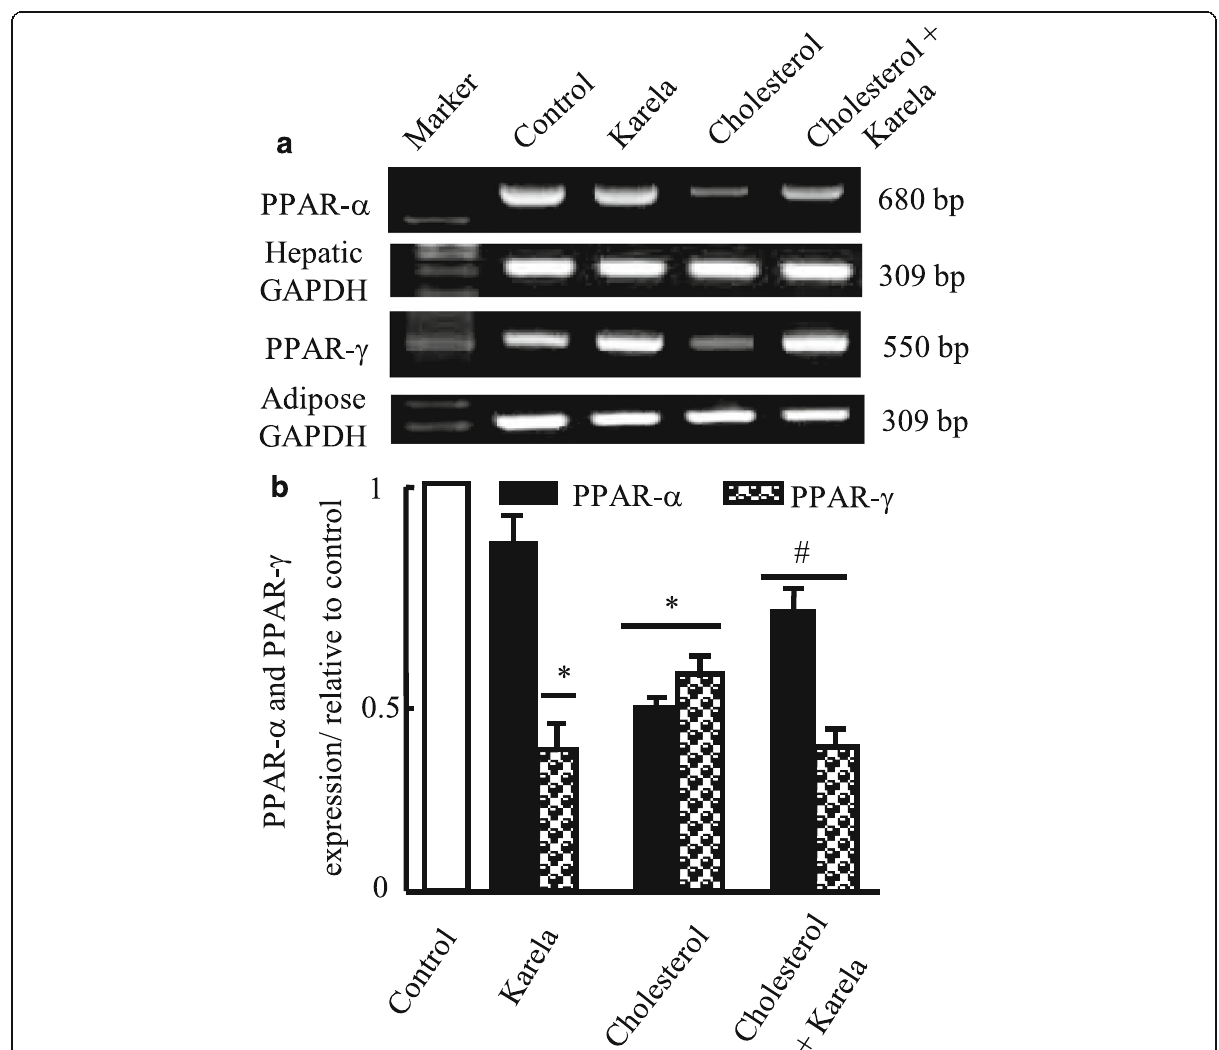
Fig. 6 Protective effect of karela on changes in PPAR- α and PPAR- γ expression induced by hypercholesterolemia in liver and adipose tissue. Hypercho- lesterolemic rats were administered karela for 4 consecutive weeks. Total RNA was extracted from liver tissues and the expressions PPAR- α and PPAR- γ were analyzed by semi-quantitative RT-PCR analysis. Values are means ± SE of 10 rats. * P < 0.05 Vs control group; # P < 0.05 VS hypercholesterolemic group. Upper panels ( a ) are mRNA expression of examined genes. Lower columns ( b ) are densitometric analysis of gene expression for upper